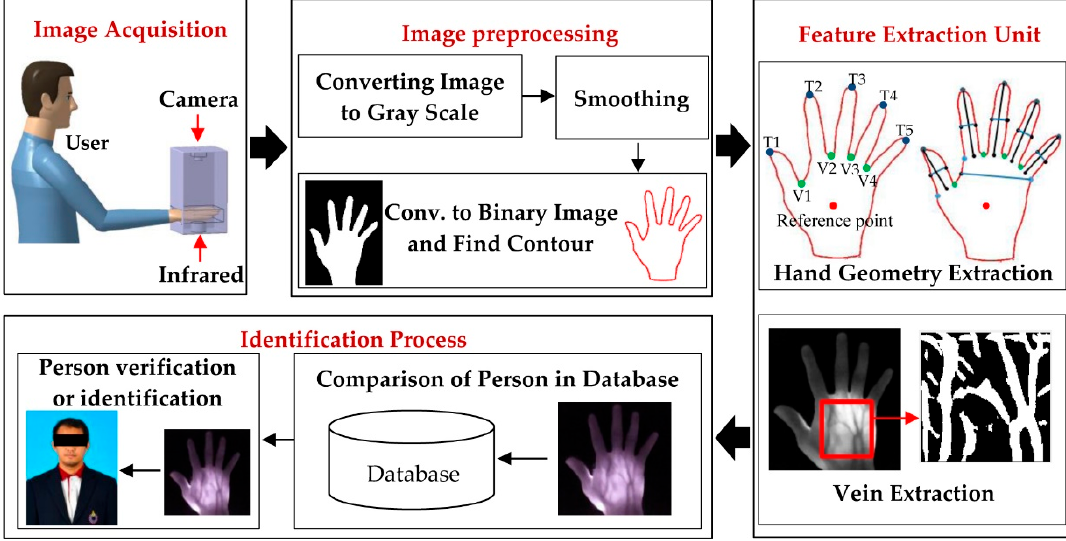
Figure 1. Proposed contactless human recognition using the dorsal vein pattern.